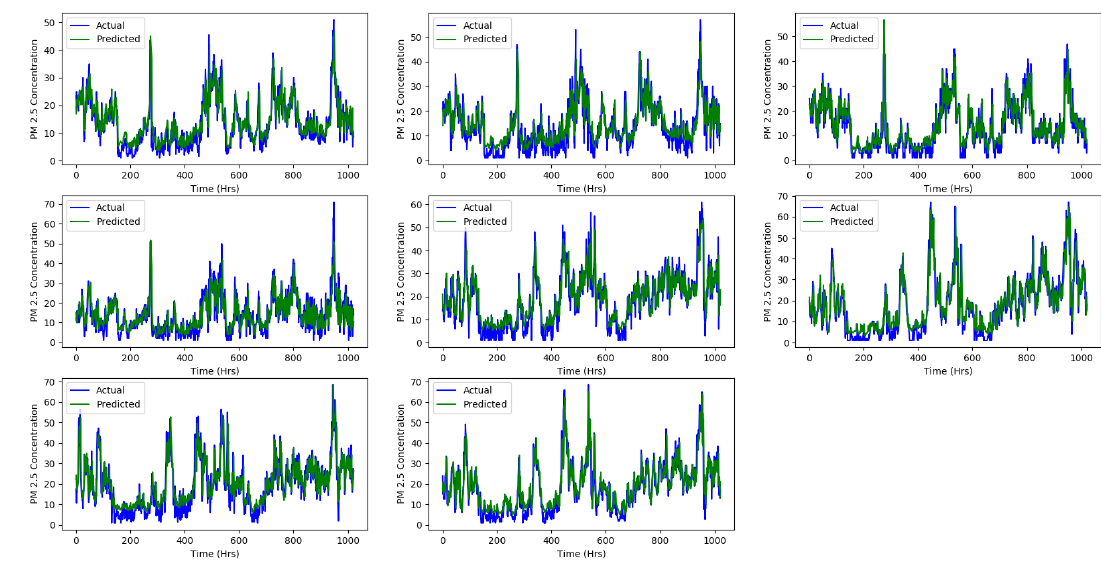
Figure 5. The predicted results of XGB.